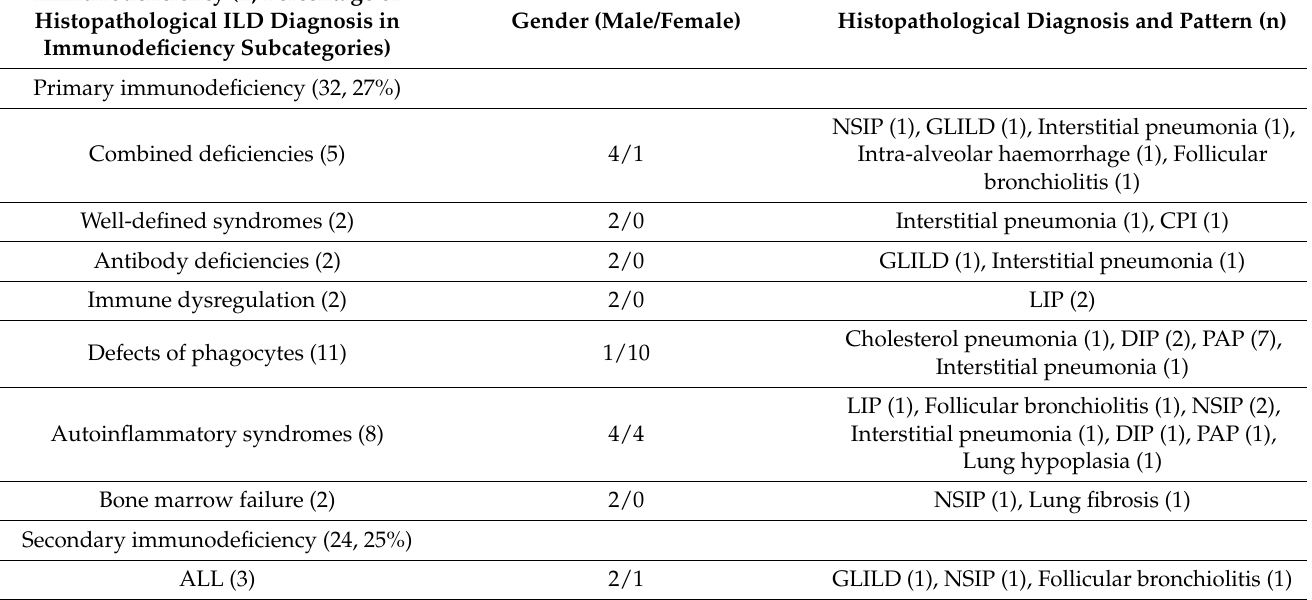
Table 6. Histopathological ILD diagnosis observed in 56 patients with immunodeficiencies and a lung